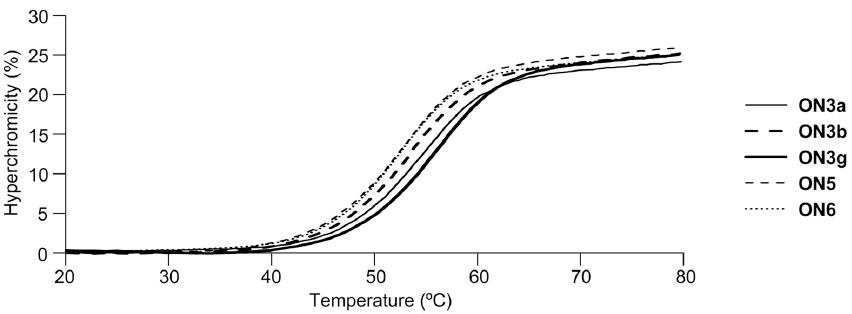
Figure 4. Representative UV-melting profiles of the duplexes formed with ssDNA and modified oligonucleotides. Table 2. T m values of duplexes containing modified oligonucleotides 1 .